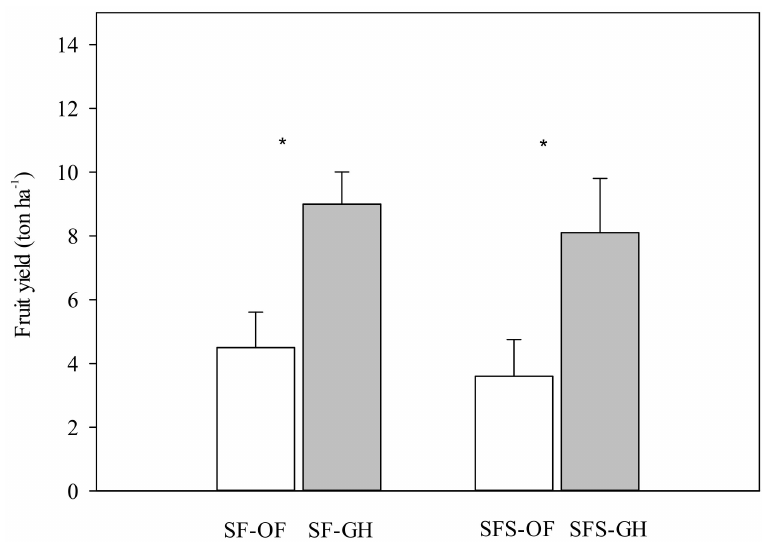
Figure 4. Fruit yield as affected by starfish (SF)- and starfish + seaweed (SFS)-liquid fertilizers applied in open-field (OF) and greenhouse (GH) cultivated red peppers. Bars represent the error of the mean. * significantly different mean values (n = 3 plants) between treatments for each system at p ≤